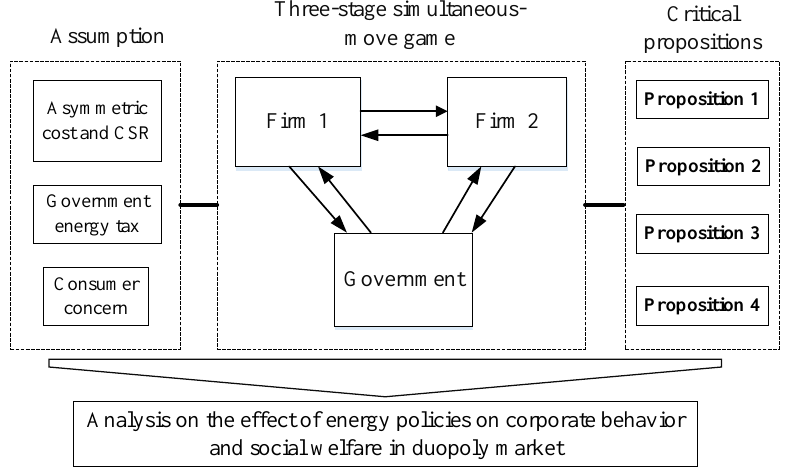
Figure 1. Flowchart of the modeling method.